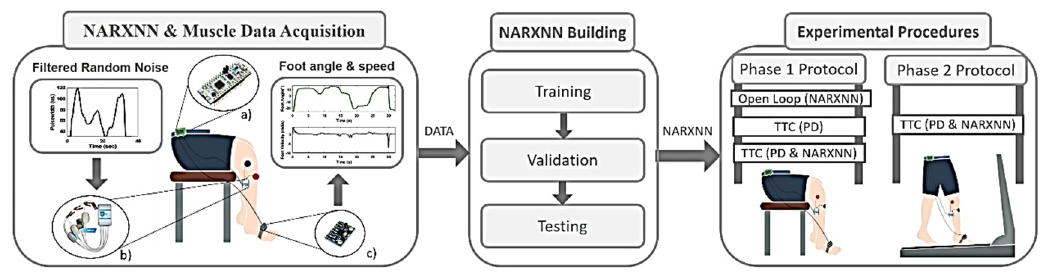
Figure 1. Methodology overview. NARXNN & Muscle Data Acquisition: Subject foot angle and angular speed (output) are recorded after TA muscle stimulation using filtered random noise as pulse width (input). ( a ) STM NUCLEO-32F303K8 ® microcontroller; ( b ) ISTim stimulator ( c ) Wearable Inertial Measurement Unit. Pulse width values and foot kinematics (DATA) are used in NARXNN Building to train, validate and built the inverse NARXNN model (input: foot kinematics; output: pulse width). The obtained inverse NARXNN is used in the Experimental Procedures to test trajectory tracking control (TTC) and open loop control strategies under a two-phase experimental protocol.